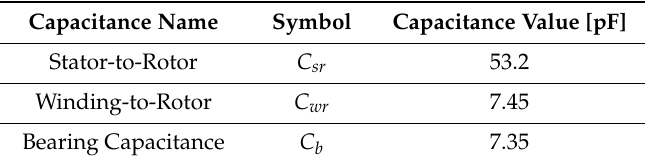
Table 1. Motor parasitic capacitances (calculated).